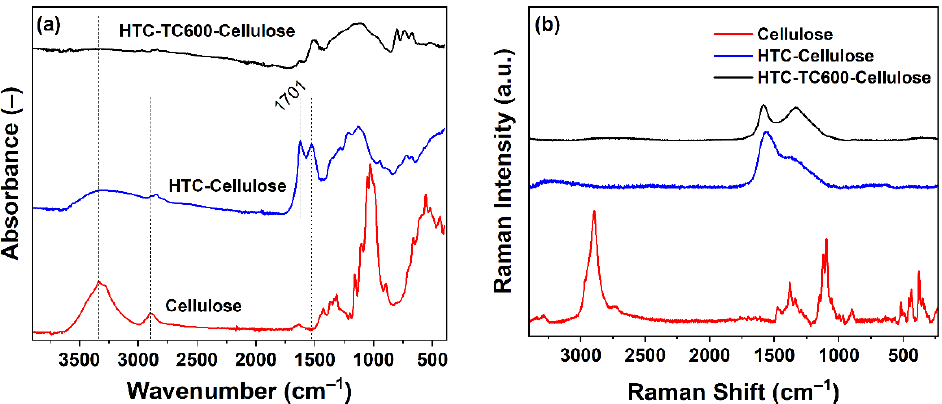
Figure 3. FTIR ( a ) and Raman ( b ) spectra of the cellulose, HTC-Cellulose and HTC-TC600-Cellulose particles.